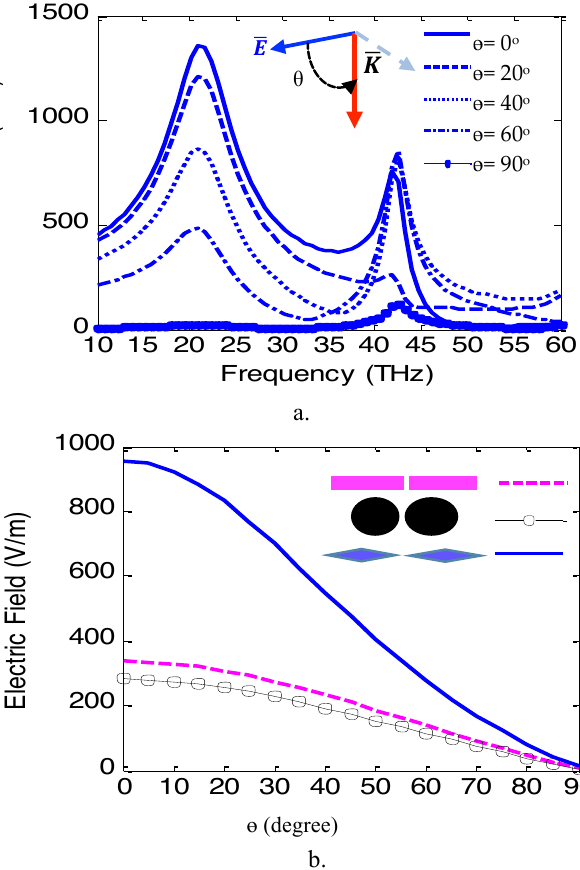
Figure 11a. T he electric field variation versus frequency for rhombic dipole IR - nanoantenna on a dielectric substrate with h=150 nm, w=5 µ m, t=50 nm, gap=10 nm, L ϕ =0 and different values for ɵ , b. The electric field variation versus ɵ for different shapes of the dipole IR - nanoantenna on a dielectric substrate at 28.3 THz.